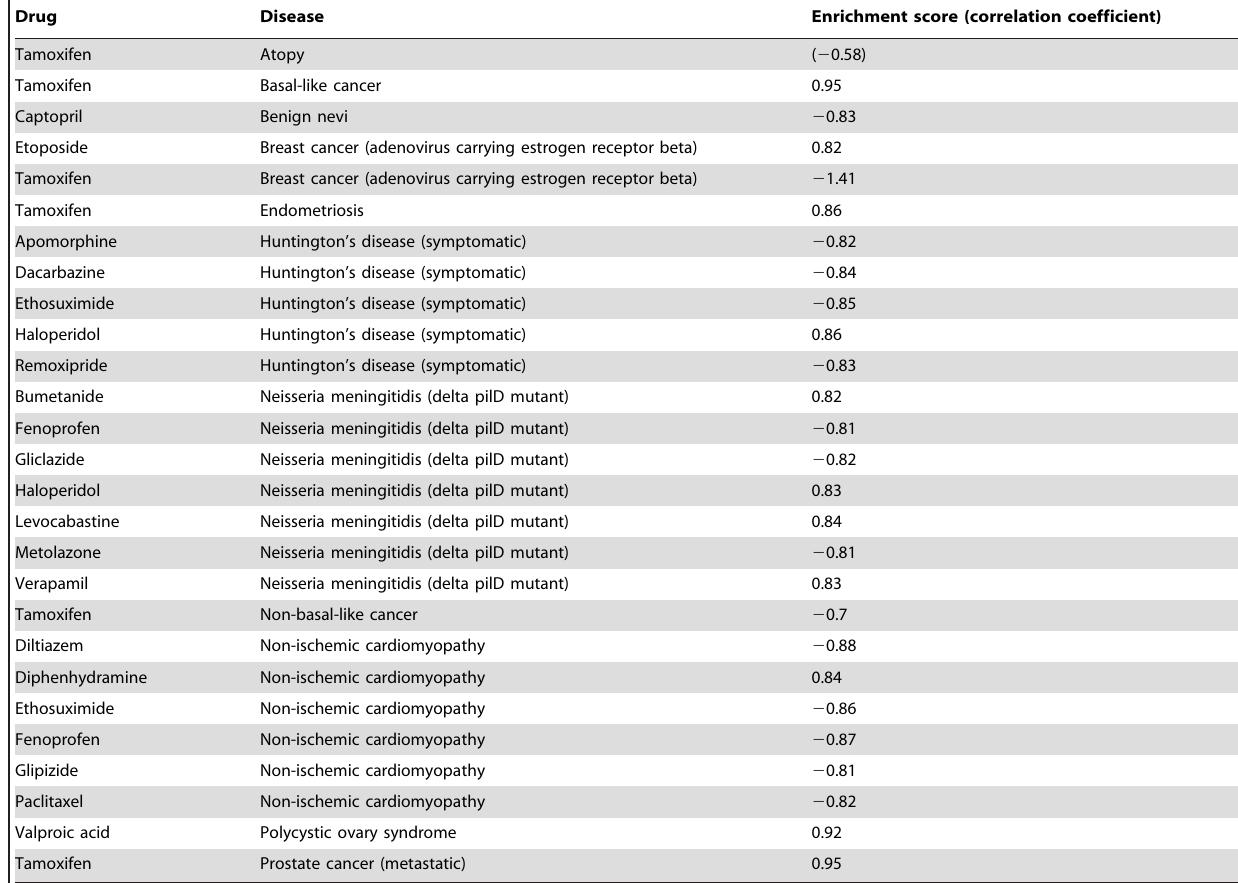
Drug Disease Enrichment score (correlation